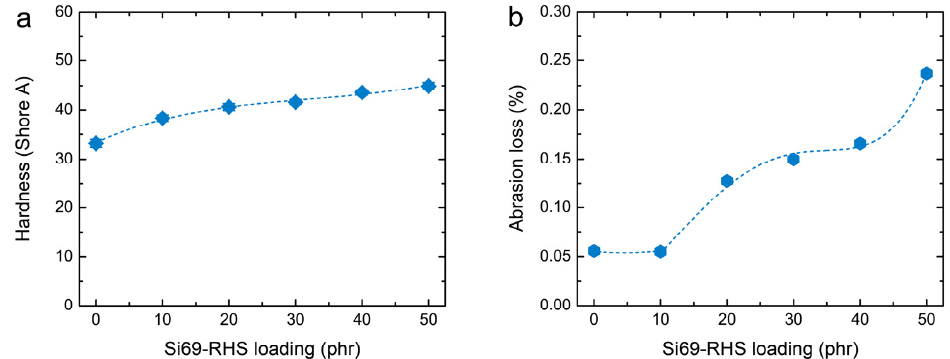
Figure 10. ( a ) Hardness (Shore A) and ( b ) abrasion loss of the NR composites filled with various Si69-RHS loadings.